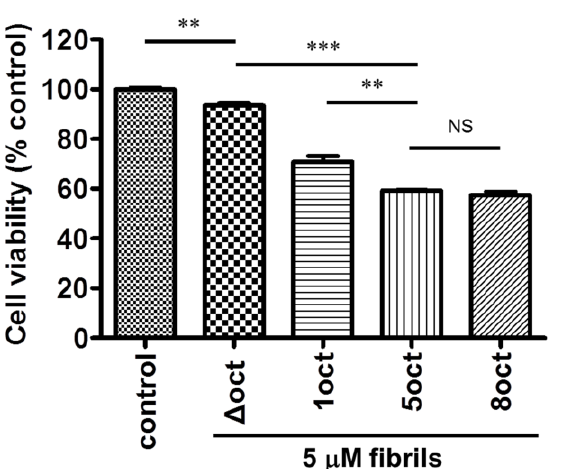
Figure 7. Cell viability of N2a cells upon treatment with fibrils converted from four PrP variants. The control sample is N2a cells without fibril treatment. **: p < 0.01, ***: p < 0.001, NS: non-significant.